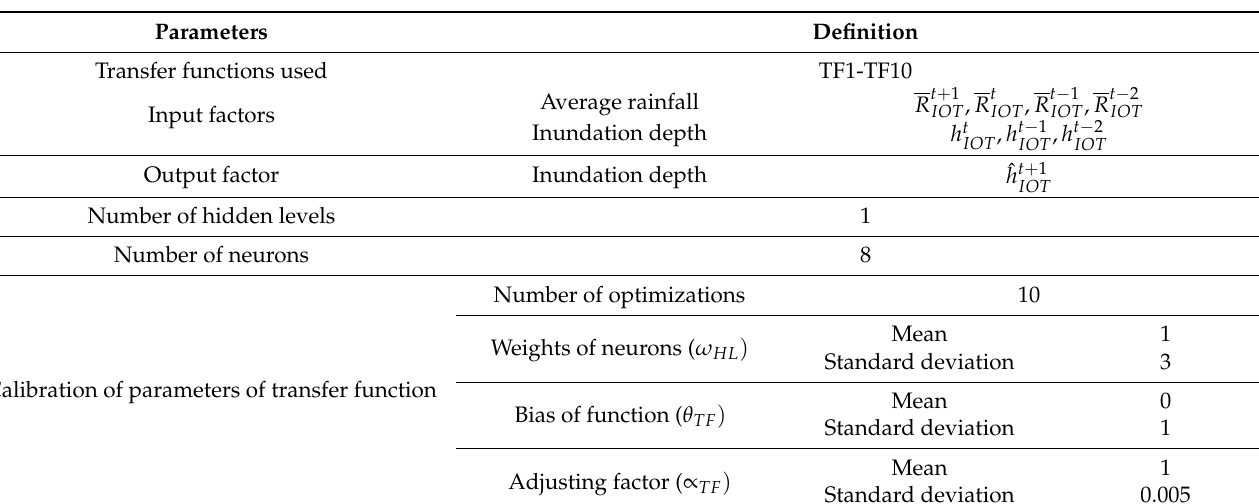
Figure 11. Summary for the estimation of the number of hidden neurons via various methods. Table 4. Definition of parameters used in the proposed ANN-GA-SA_MTF